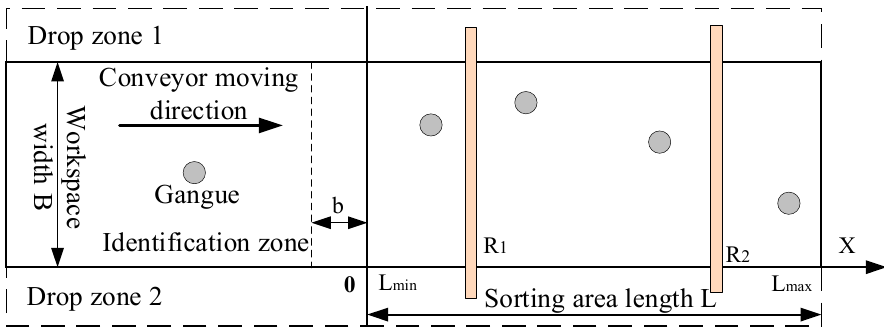
Figure 3. Model of coal and gangue sorting robot working area.